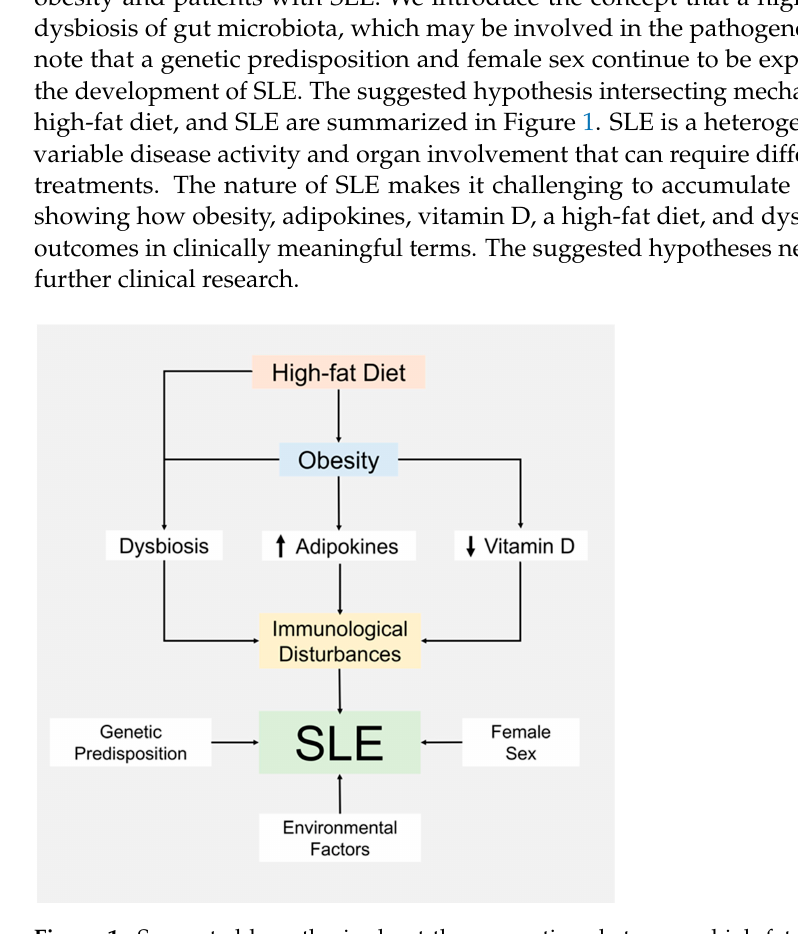
Figure 1. Suggested hypothesis about the connections between a high-fat diet, obesity, and the pathogenesis of SLE.